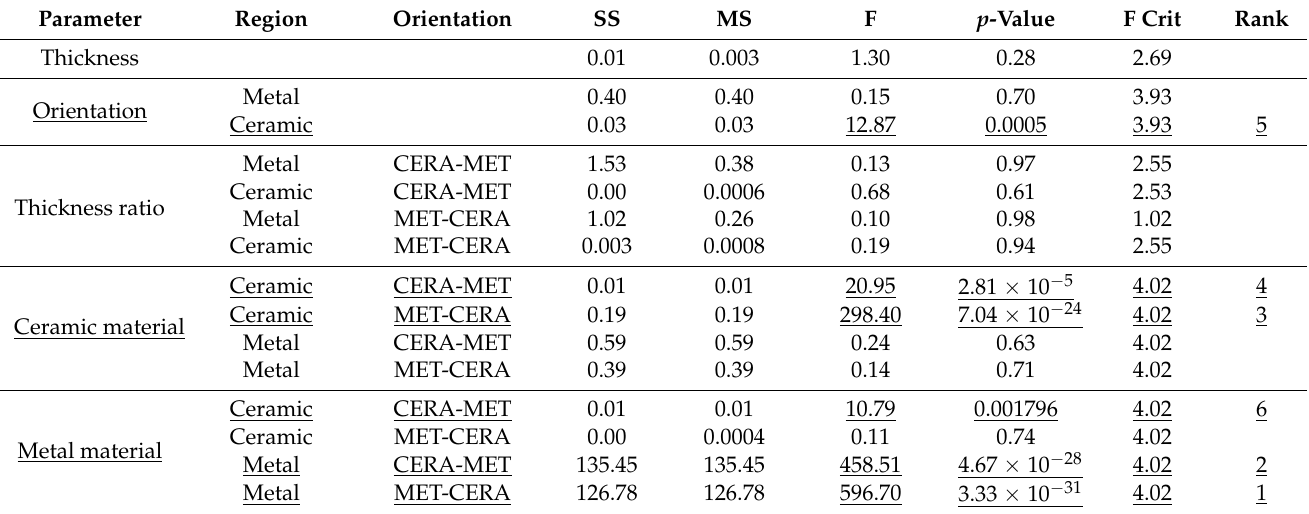
Table A5. Metal–Ceramic composite SSF. Statistically significant parameters are underlined.